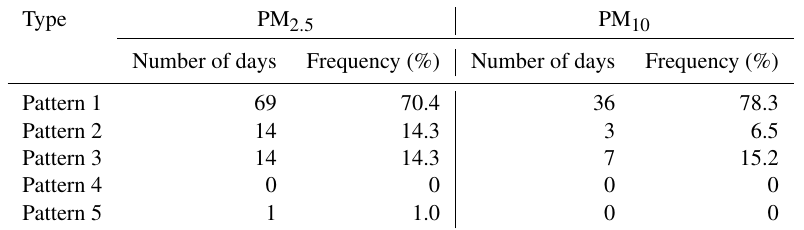
Table 4. The occurrence frequencies of synoptic weather patterns during regional severe PM 2 . 5 and PM 10 pollution episodes. Type PM 2 .